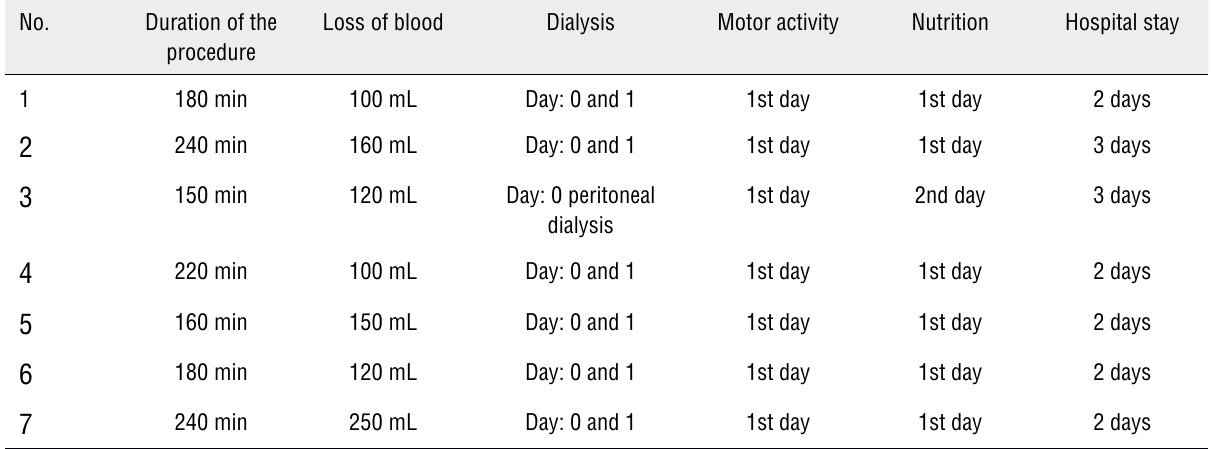
Table 2 - The results of the nephrectomy.